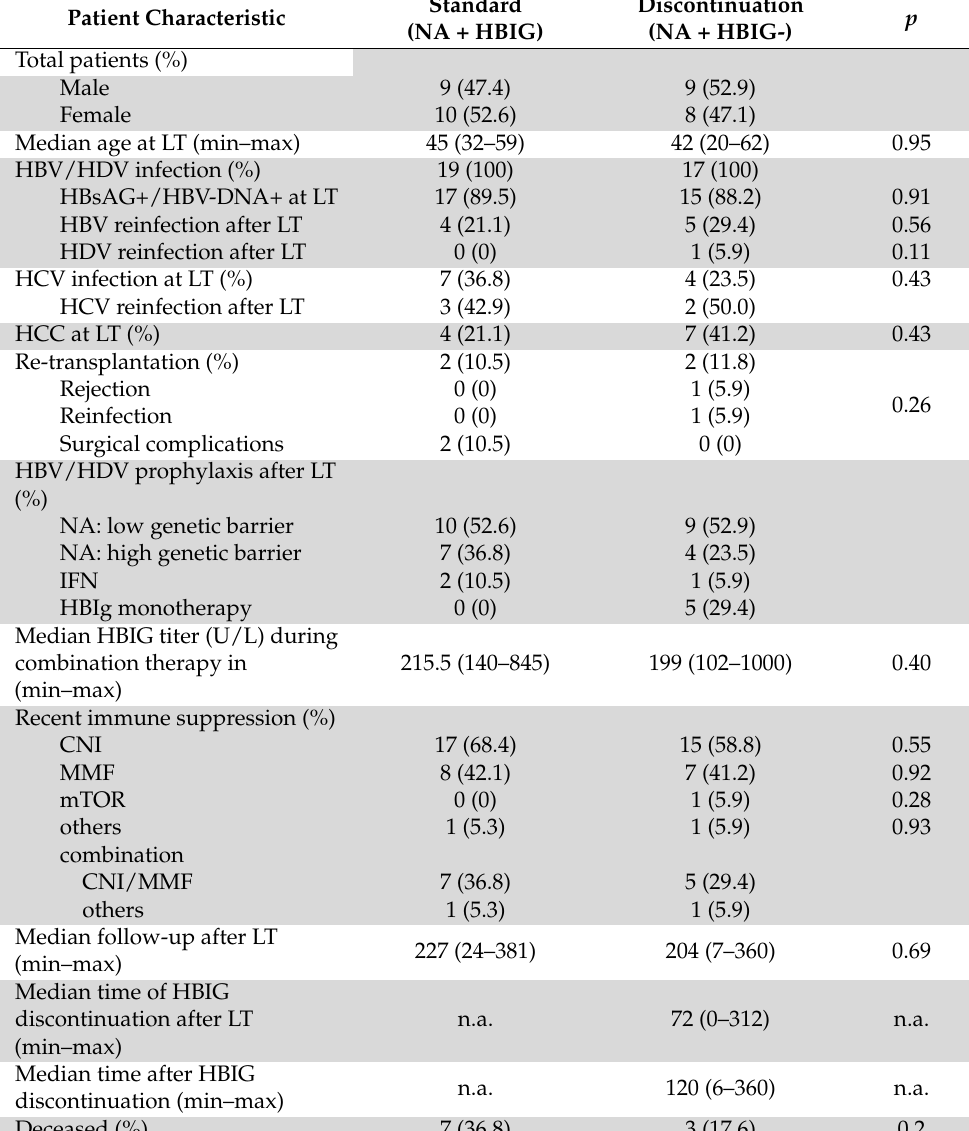
Table 1. Patient characteristics. CNI—calcineurin inhibitor; LT—liver transplantation; HCC— hepatocellular cancer; mTOR—mTOR Inhibitor; MMF—mycophenolate mofetil; HBIG—hepatitis B immunoglobulin; NA—nucleos(t)ide analog; standard group–life-long combination of HBIG with NA; discontinuation group—NA-based and discontinuation of